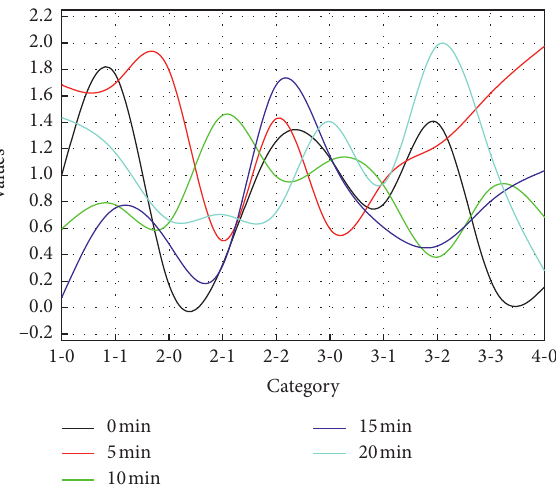
Figure 5: Hurst index